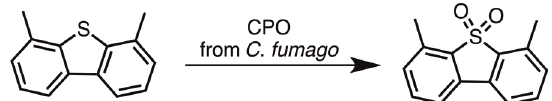
Figure 28 - Oxidation of 4,6-dimethyl dibenzothiophene by CPO immobilized on silica-based materials. (Montiel et al. 2007).